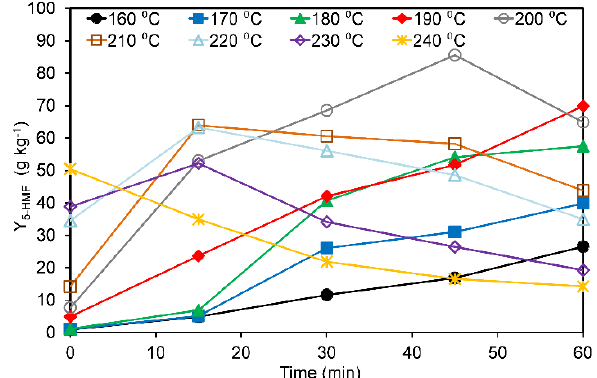
Figure 1. Effects of reaction temperature and time on the yield of 5 - HMF contained in the WS fractions obtained from hydrothermal decomposition of PF - SBP. obtained from hydrothermal decomposition of